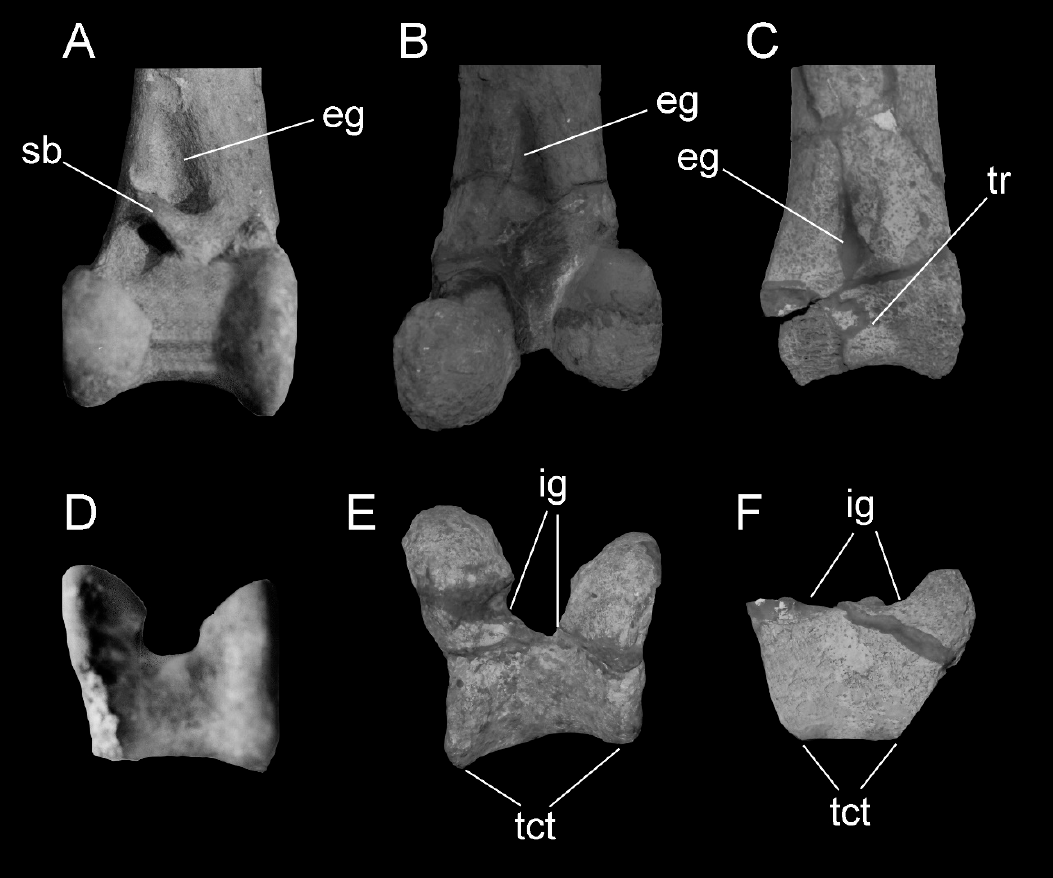
Figure 5. Distal end of left tibiotarsus of ( A , D ) Onactornis pozzii (MACN Pv-6554); ( B , E ) Brontornis burmeisteri (MLP 20-92/93); ( C , F ) Brontornis burmeisteri (MLP 20-110) in ( A – C ) anterior; and ( D – F ) distal views. Abbreviations . eg, extensor groove; ig, anterior intercondylar groove; sb, supratendinal bridge; tct, trochlea cartilaginis tibialis ; tr, transverse ridge. Not to scale.